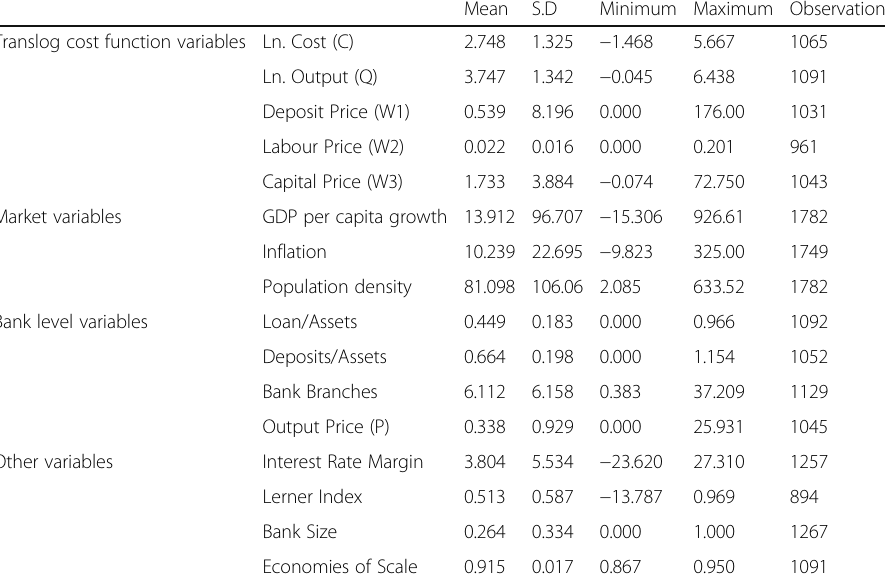
Table 3 Summary